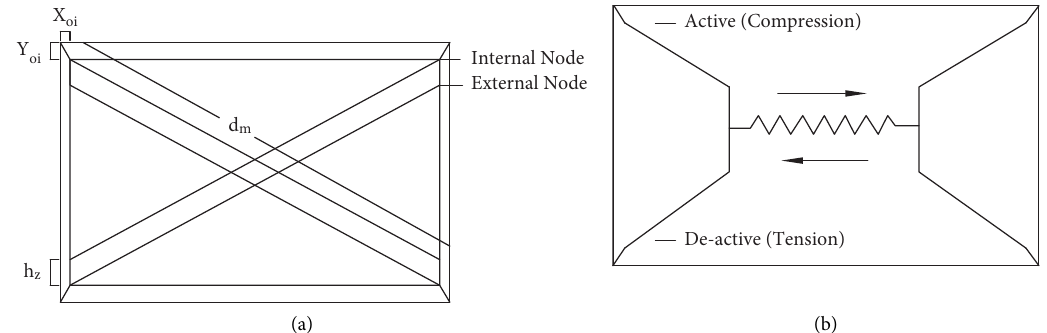
Figure 6: Inelastic infill panel element (developed by Crisafulli [43]).